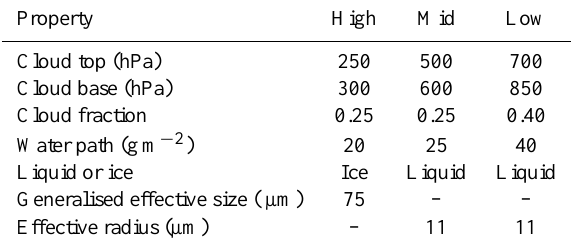
Table 3. Cloud properties used in case study. f total =0.66.